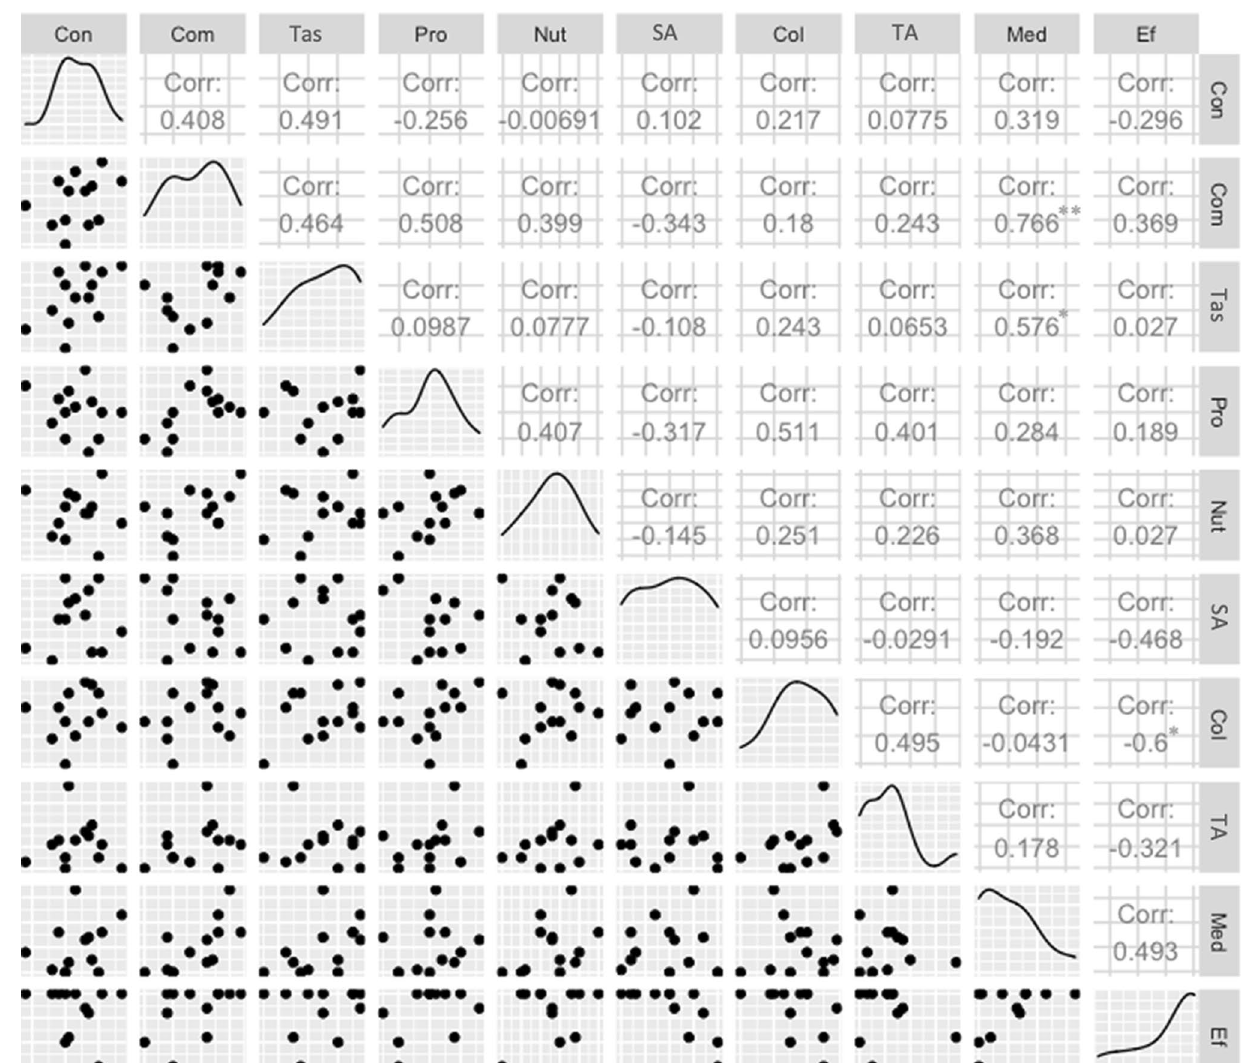
Figure 5. Correlogram (Spearman’s correlation) between the attributes measured based on the local perception of the residents of the rural settlement Dom Helder Câmara, in the municipality of Murici, state of Alagoas, northeastern Brazil. Cons consumption intensity, Com commercial potential, Tas Taste, Pro propagation potential, Nut nutritional potential, SA spatial availability of the part of the plant used as food, Col Ease of collection, TA temporal availability of the part of the plant used as food, Med medicinal potential, Ef absence of adverse effects; *p < 0.05; **p < settlement were mentioned. These factors together may have led to low richness and low regularity in citations. However, hypothesis-oriented studies need to address these issues. Besides being highly heterogeneous, knowledge on wild food plants cannot be explained by socioeconomic factors. This may be partially related to the fact that people with different biocultural backgrounds converged to the community, and the dynamics of learning about food plants were different in these diverse locations, hin- dering the emergence of internal standards. In addition, our findings are in line with studies outside the context of settlements with regards to age 18–20 or gender 20,32 , which indicates that, for this domain, the ways (and the moments) knowledge is acquired among individuals can vary greatly. Regarding the profile of wild food plants, the predominance of fruits as the main part used is in line with many studies in tropical regions 20,23,33,38 , although it contrasts to most studies undertaken in temperate and subtropical regions 35,36,39–41 . This pattern can highlight the fundamental role of the environment in the selection of wild food plants. However, this hypothesis should be properly tested using meta-analytical tools. The predominance of forest species among the wild food plants cited in the Dom Helder settlement dif- fers from most findings in the literature for agricultural populations. According to investigations in the con- text of local farmers, these groups usually collect mainly species that are typical of anthropogenic areas, when compared to plants from pristine ecosystems, especially when forest areas are being lost or are distant from the community 42–44 . Studies on the role of availability in the selection of food plants have shown contrasting